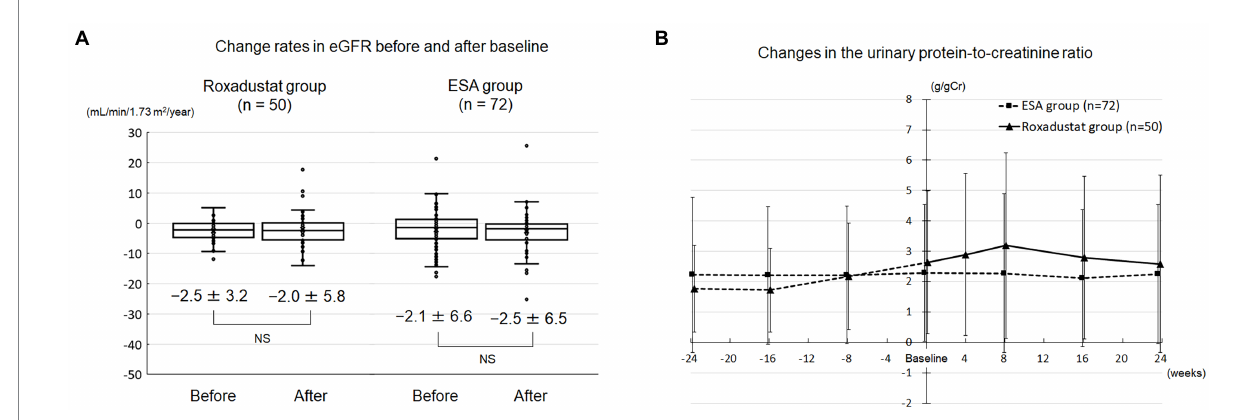
FIGURE 4 Renal function and proteinuria. (A) Change rates in the eGFR before and after baseline in the roxadustat and ESA groups. (B) Changes in the urinary protein-to-creatinine ratio in the roxadustat and ESA groups. eGFR, estimated glomerular filtration rate; ESA, erythropoiesis-stimulating agent; NS, not significant.